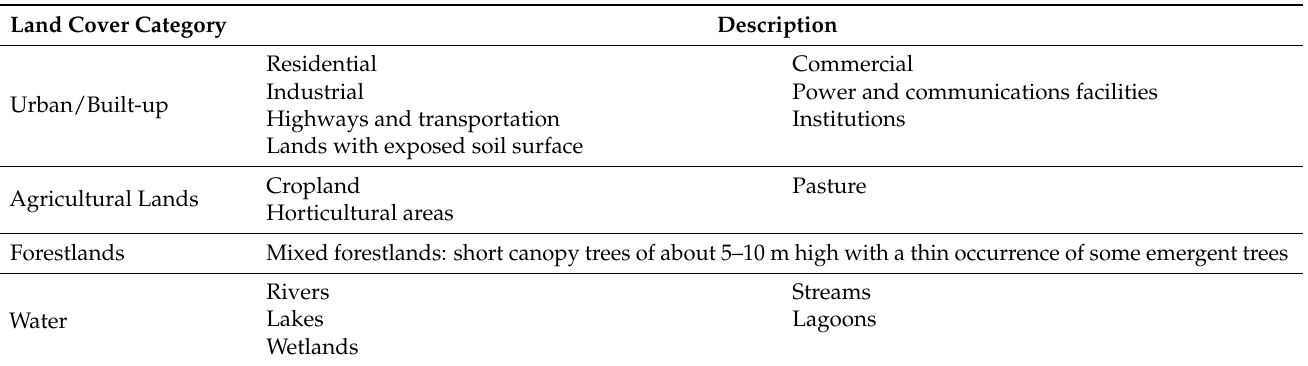
Table 2. The land use land cover classes adopted for the